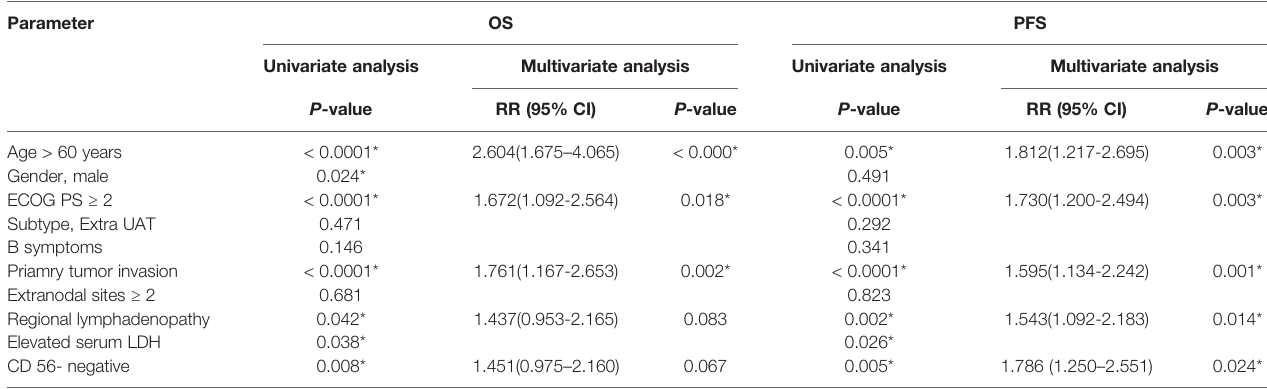
TABLE 4 | Results of univariate and multivariate analyses of prognostic factors for OS and PFS in patients with Stage I/II. Parameter OS PFS Univariate analysis Multivariate analysis